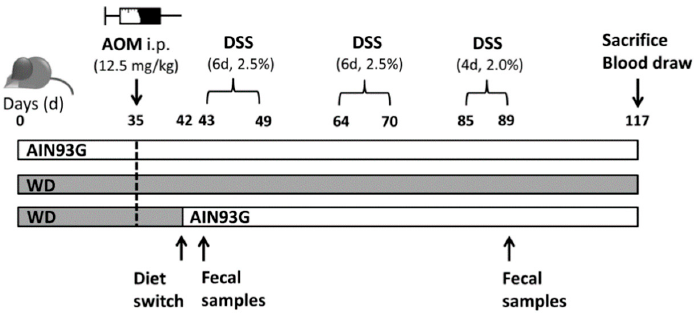
Figure 1. Graphical representation of the treatment protocol. Three groups of female BALB/c mice received either the AIN93G diet or the Western-style diet (WD) for 35 days, before they received azoxymethane (AOM) intraperitoneal (i.p.) one day before the start of the first cycle of dextran sulfate sodium salt (DSS), in one group, the WD was switched to the AIN93G diet. The mice were sacrificed 28 days after the third cycle of DSS.